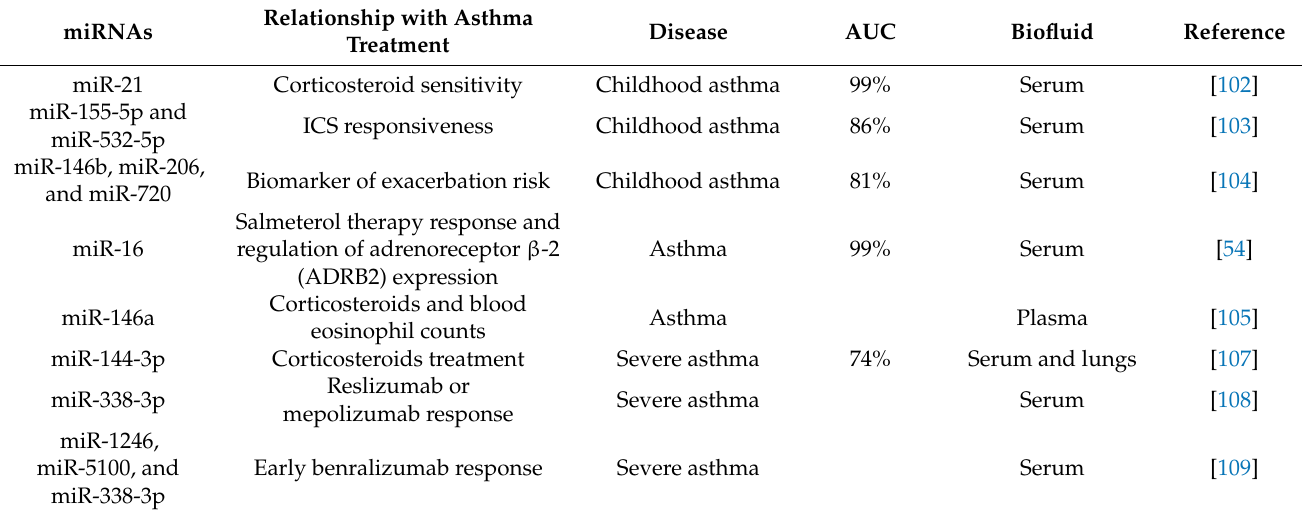
Table 2. miRNAs and their relationships with asthma